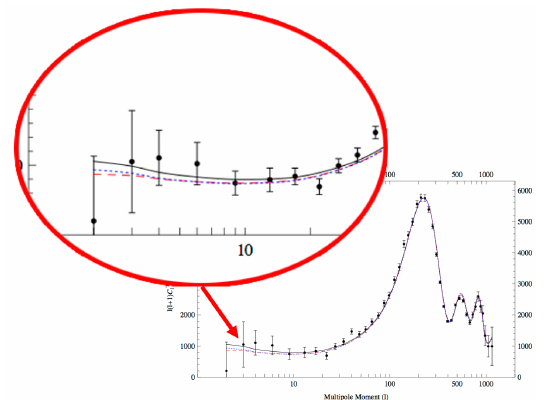
Figure 4. Suppression of the lowest modes of the power spectrum of the CMB induced by the existence of a pre-inflationary stage of the universe dominated by: (i) a network of frustrated domain walls (dotted blue line); and (ii) a network of frustrated cosmic strings (dashed red line). Picture elaborated from the original figures of Ref.